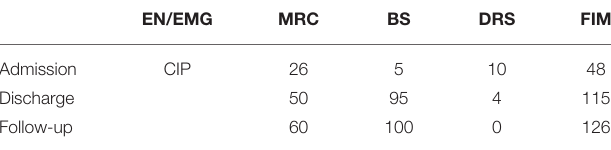
TABLE 2 | Strength and functional measures